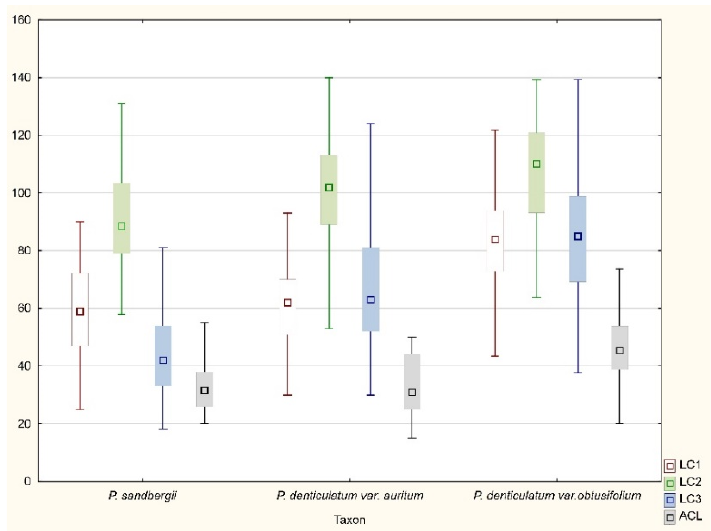
Figure 15. The range of variability of the examined features. Explanation: LC1, length of cells from the top; LC2, the middle part; LC3, from the lower part of the leaf; ACL, length of alar cells (length in μ m).